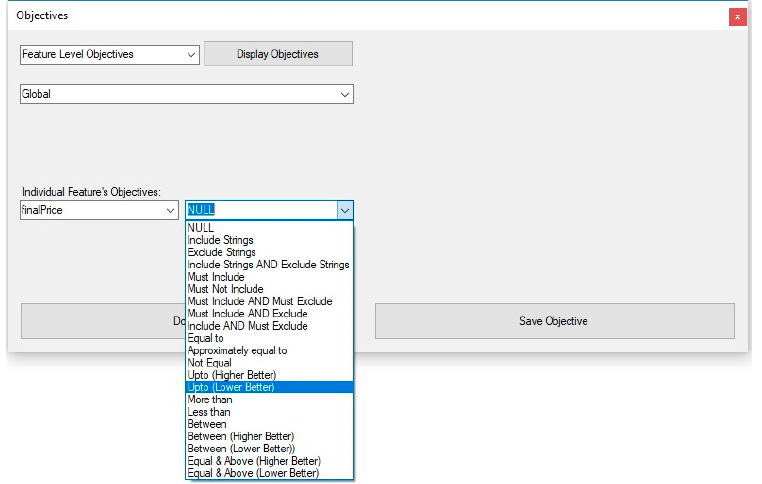
Figure 6. FSE setting feature level objectives.